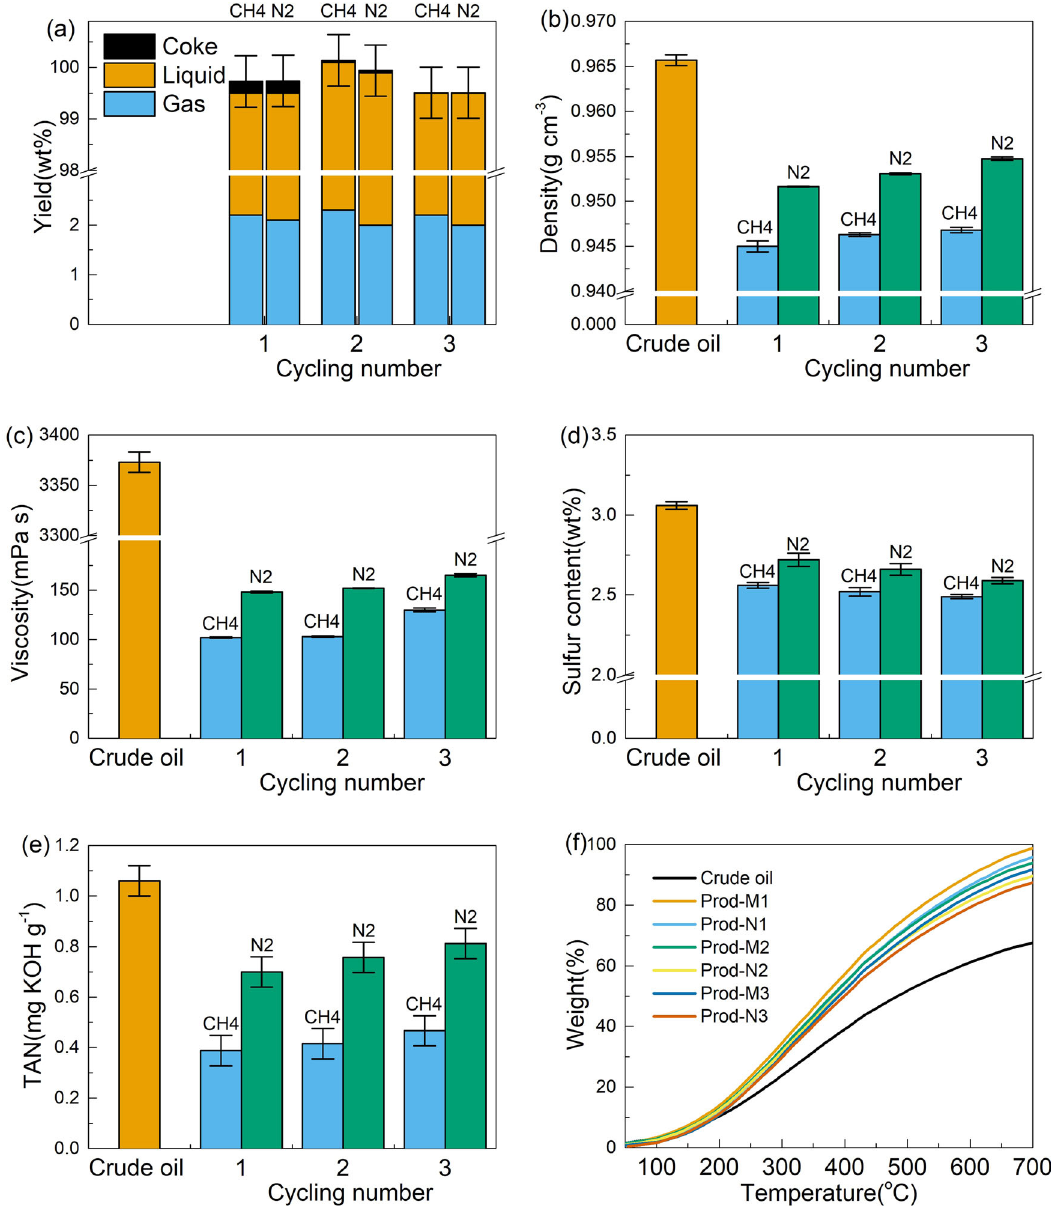
Fig. 1 Properties of crude oil and upgrading products over catalysts with different reaction cycles under methane and nitrogen. a Gas, liquid, and coke yield, b density, c viscosity, d sulfur content, e TAN, f boiling curve derived from SDA. The error bars represent the standard deviation of the measurements.